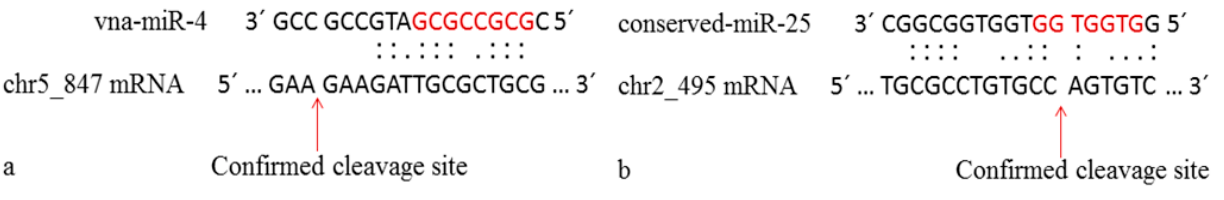
Figure 5. Schematic representation of the experimentally validated cleavage sites of the target mRNAs; ( a )—evm.model.chr5_1271NY.847 and ( b )—evm.model.chr2_1770NN.495; the seed region of mature milRNA is highlighted in